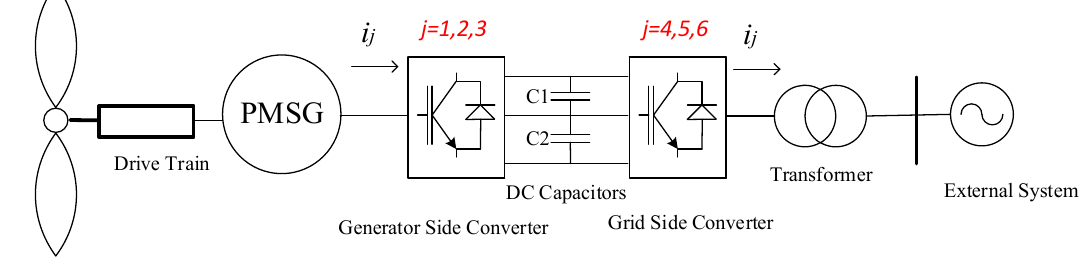
Figure 7. The configuration of WT-PMSG system.